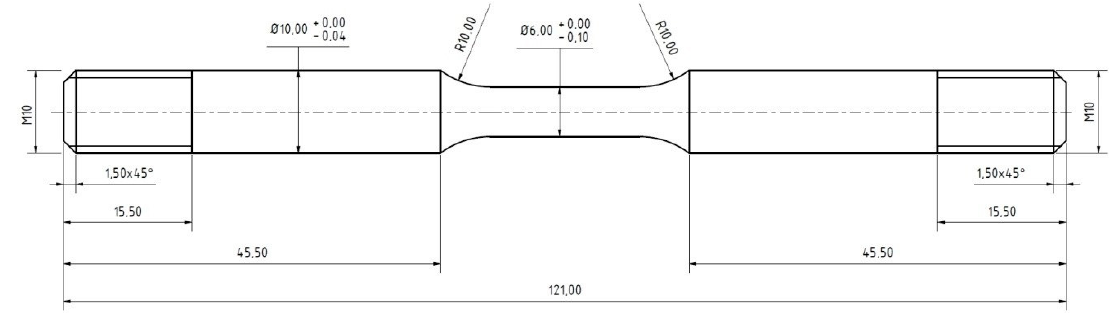
Figure 9. Samples used to measure mechanical properties after applying a temperature cycle in the Gleeble 3500 (unit: mm).